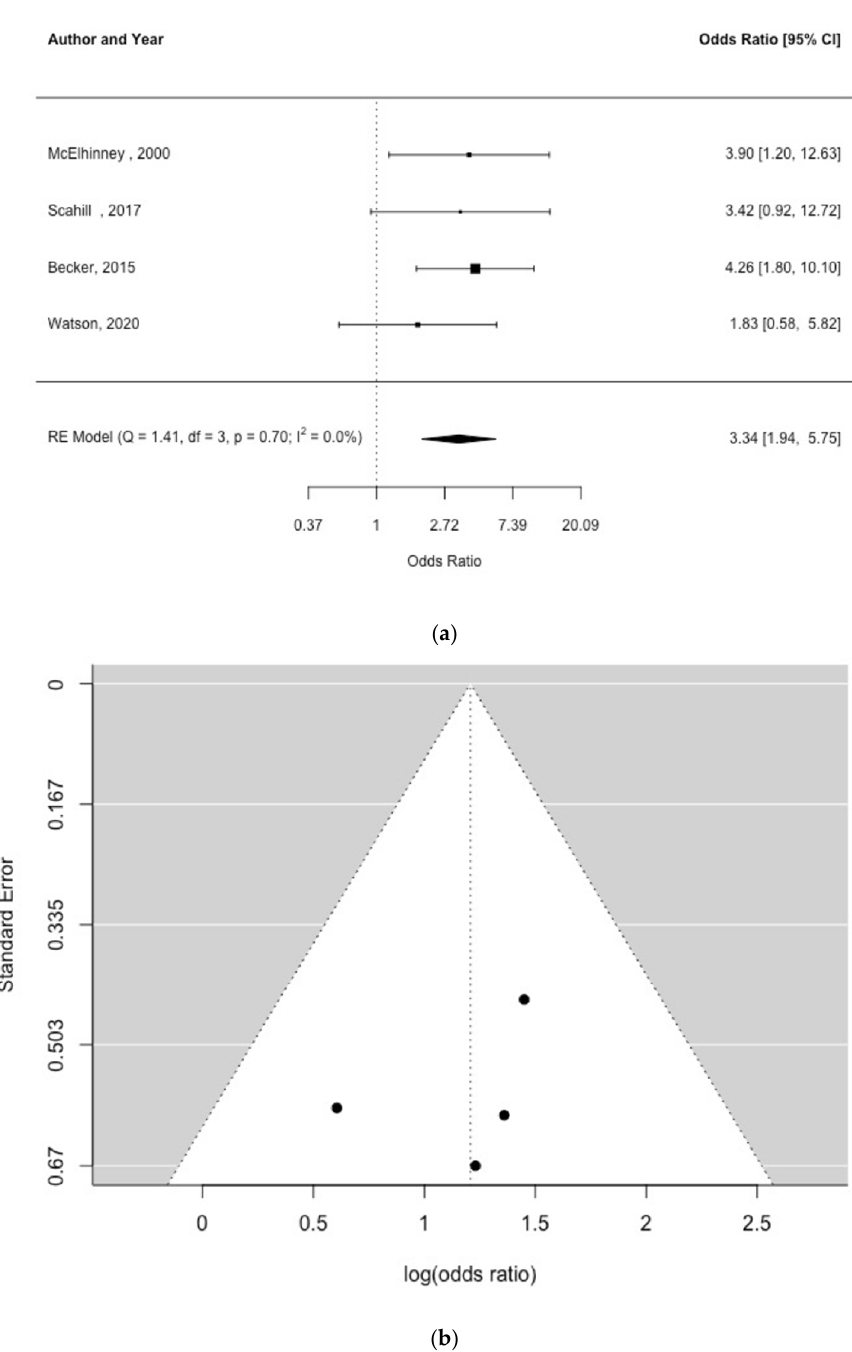
Figure 5. Forest plot ( a ) and funnel plot ( b ) of study effect estimates for premature birth and NEC [shown as odds ratios and log (odds ratios), respectively] [5,24–26]. Egger’s test did not indicate funnel plot asymmetry [ p = 0.581].